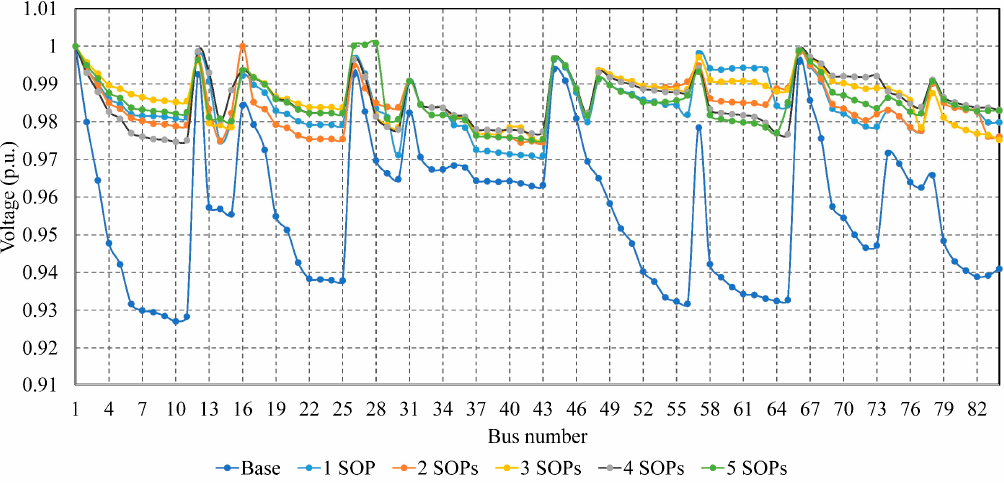
Figure 8. Improvement of the voltage profile at the normal loading condition with SOPs’ power loss considered: Scenario 9.